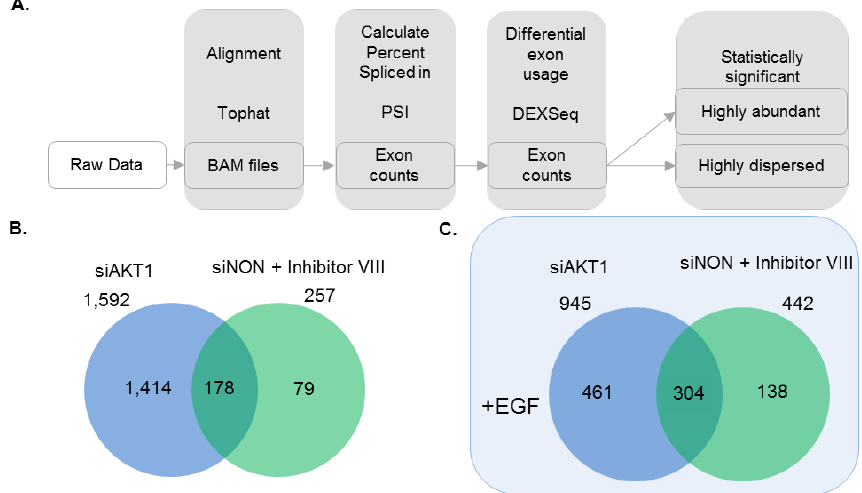
Figure 6. Identification of splice variants in AKT1-dependent transcriptome. ( A ) Tools and pipeline to identify the splice variants; and ( B , C ) comparative analysis of splice variants identified in each experimental conditions without ( B ) or with ( C ) EGF stimulation. Only the spliced genes showing at least 2-fold change with a p -value < 0.05 are considered from all the studies.